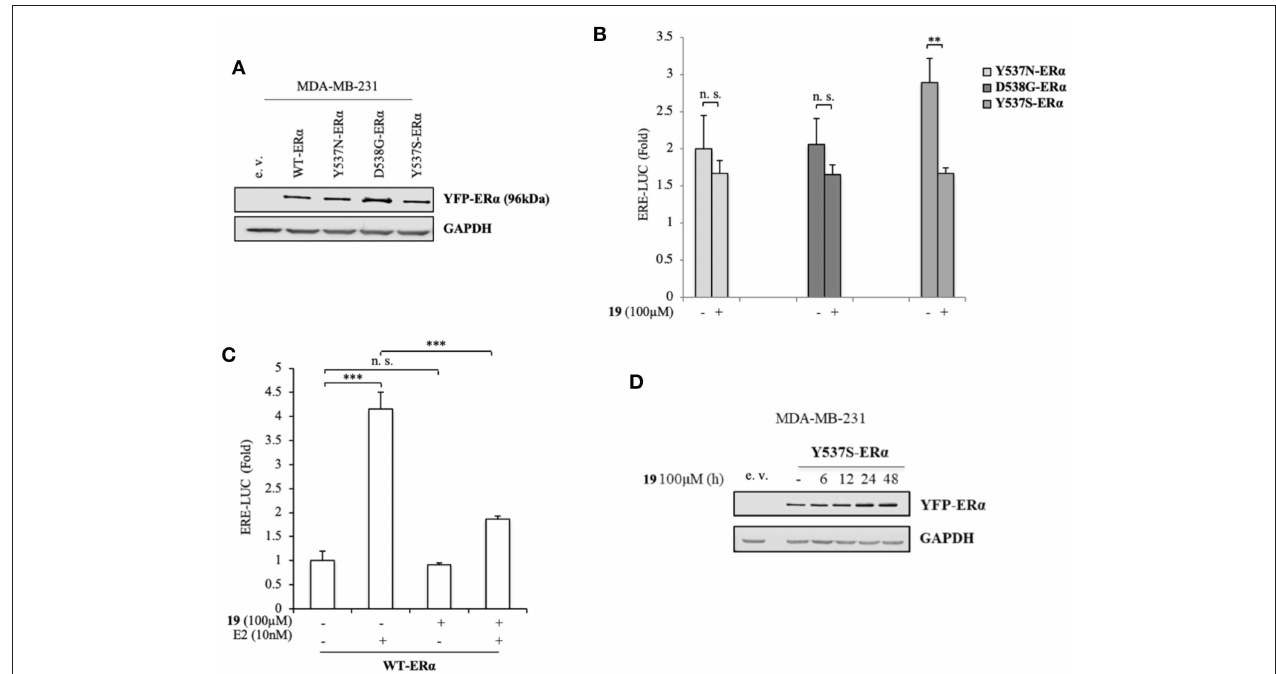
FIGURE 3 | Impact of compound 19 on activation of WT, Y537N, and D538G ER α in MDA-MB-231 breast cancer cells. (A) Immunoblotting showing exogenous ER α protein expression in ER α -negative MDA-MB-231 breast cancer cells transiently transfected with an empty vector (e. v.), YFP-WT, YFP-Y537N, YFP-Y537S, or YFP-D538G ER α expressing vectors. GAPDH was used as a control for equal loading and transfer. (B) ER α -transactivation assay in MDA-MB-231 cells transiently transfected with YFP-Y537N, YFP-Y537S, or YFP-D538G ER α expressing vectors plus an ERE-luciferase reporter (XETL), and treated with vehicle (-) or the compound 19 at 100 µ M. Data are reported as fold change relative to WT-ER α expressing cells. (C) ER α -transactivation assay in MDA-MB-231 cells transiently transfected with YFP-WT plus XETL plasmid, and treated with vehicle (-) or the compound 19 (100 µ M) in the presence or not of 17 β -estradiol (E2, 10nM). Data are reported as fold change relative to vehicle (-)-treated cells. The values represent the mean ± S. D. of three different experiments, each performed in triplicate. n. s., non-significant; ** P < 0.005; *** P < 0.0005. (D) Immunoblotting showing ER α protein expression in MDA-MB-231 breast cancer cells transiently transfected with YFP-Y537S ER α expressing vector and treated with the compound 19 (100 µ M) at the indicated time. GAPDH was used as a control for equal loading and transfer.